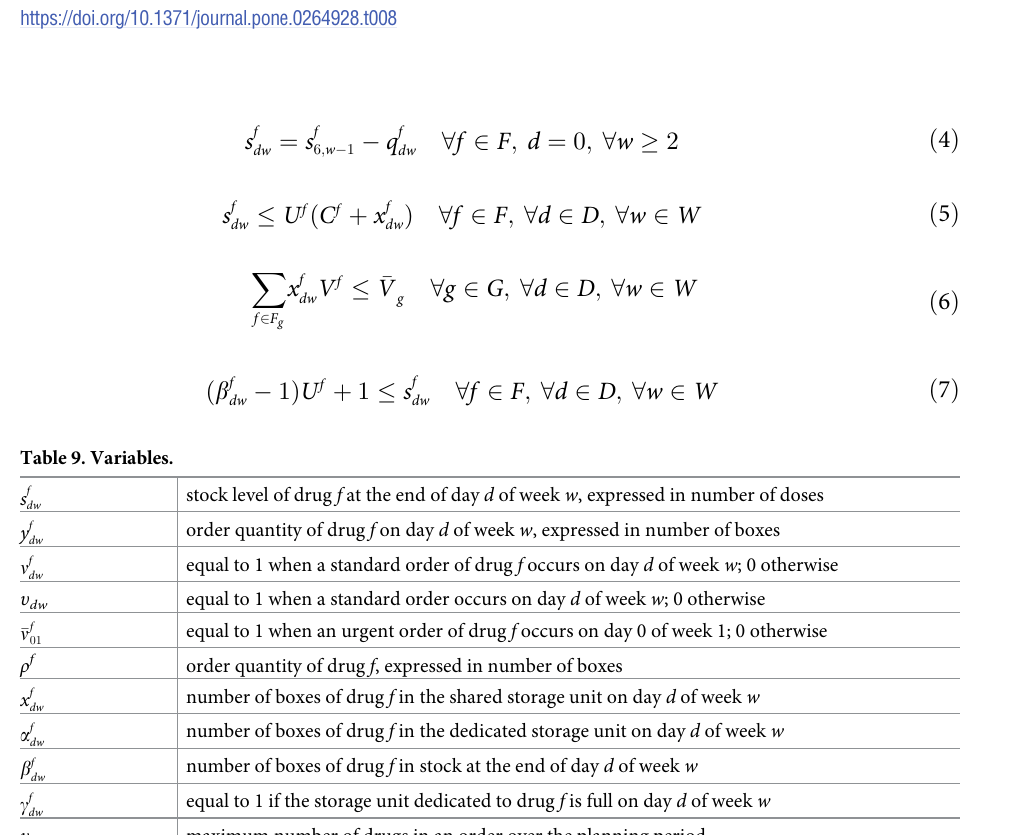
safety stock of drug f on day d of week w capacity of the storage unit dedicated to drug f —number of boxes maximum number of drug f boxes in the shared storage unit volume of a drug f box in number of units in the shared storage unit capacity of the shared storage unit for group g , expressed in number of units upper bound on the number of boxes of drug f in stock cost of an urgent order number of boxes of drug f in rush order on day 0 week 1 reference value for the level of inhomogeneity in